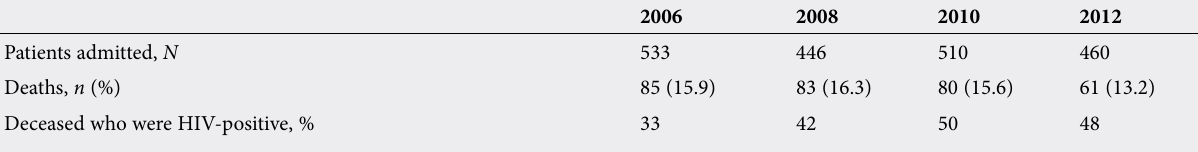
Table 1. Patient admissions, deaths and HIV status over the study